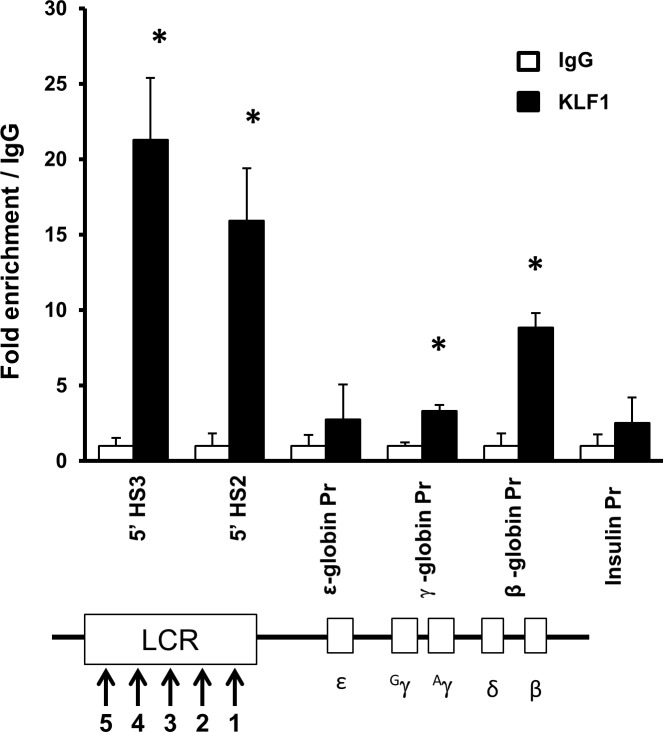
KLF1 is enriched at the locus control region (LCR) and β-globin promoter in umbilical cord blood (UCB) erythroblasts.CD34+ cells were enriched from umbilical cord blood units, expanded for eight days, and in vitro differentiated for eight days (DD8). Chromatin immunoprecipitation (ChIP) assays were performed with DD8 erythroblasts. Chromatin was incubated with either a KLF1 antibody or non-specific antibody (IgG) as a negative control (black or white bars, respectively). Precipitated chromatin was subjected to quantitative PCR (qPCR) to determine the amount of precipitated DNA from 5’HS3 and 5’HS2 in the LCR, and from the ε-, γ- and β-globin promoters. The primers for the γ-globin promoter collectively measure the Aγ- and Gγ-globin genes. The insulin promoter was used as a negative control. Pr = promoter, N = 2, error bars = standard error, * = p-value<0.05 compared to non-specific antibodies. β-globin locus not drawn to scale.